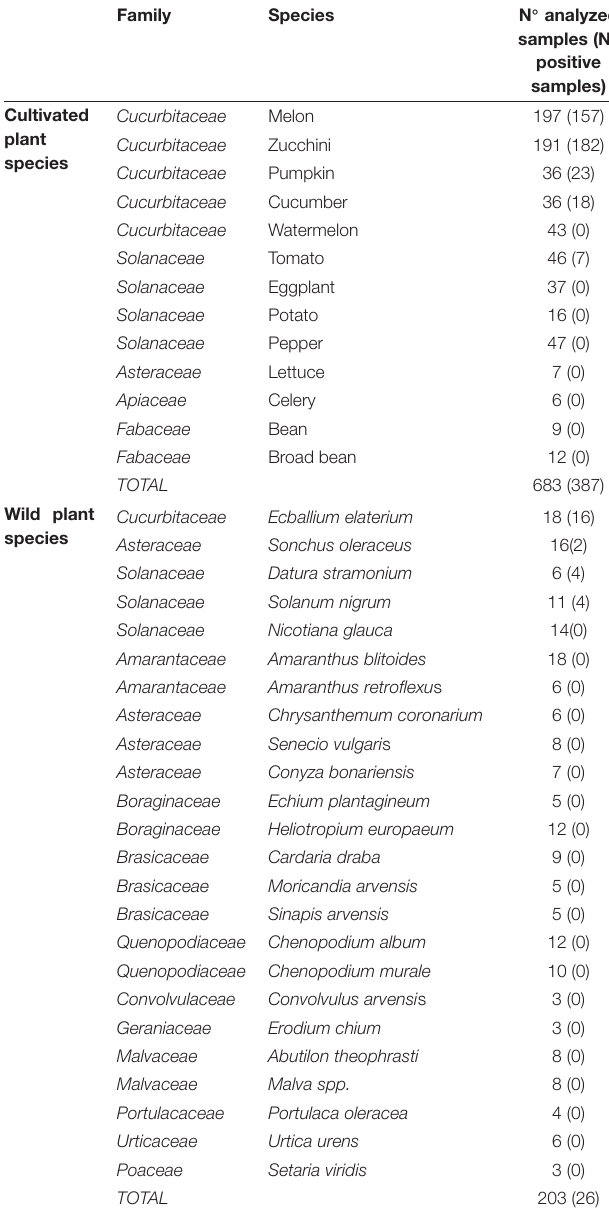
TABLE 1 | ToLCNDV detection by ELISA and tissue-print hybridization test for cultivated and wild plant samples collected in the major producing-areas in Spain for the 5 consecutive year survey